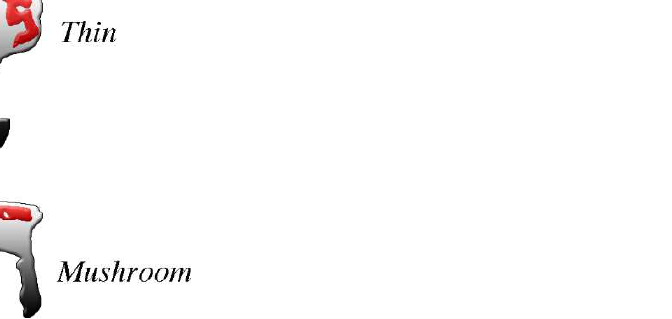
Figure 2. The four common types of post-synaptic spines are clearly different from each other. The density and shape of post-synaptic spines, abundant in excitatory neurons, change profoundly during physiological and pharmacological events. For example, changes occur during spine generation, by continuous turnover with regeneration, and by conversion of one type of spine into another. All spines exhibit abundance of PSD (red) distributed within the body in the proximity of the plasma membrane where pre-synaptic messages are received. PSDs are widely composed by adhesion molecules bound by scattered receptors, enzymes and at least some scaffolding proteins. Most PSD-bound proteins are critical for post-synaptic responses. Spines exhibit distinct shapes: stubbles do not have long necks, thus their responses are similar to those of the flat post-synapses; filopodia, often active in groups, are long but thin, with very small heads; mushroom and thin spines exhibit relative large heads, with flat and round top surfaces, respectively, connected to their dendritic fibers by long or very long necks. Their activities tend therefore to operate independently, with limited interactions with their dendritic fiber. Permission for this Figure, a fraction of Figure 2 of [36], has been obtained from Frontiers in Neuroscience.